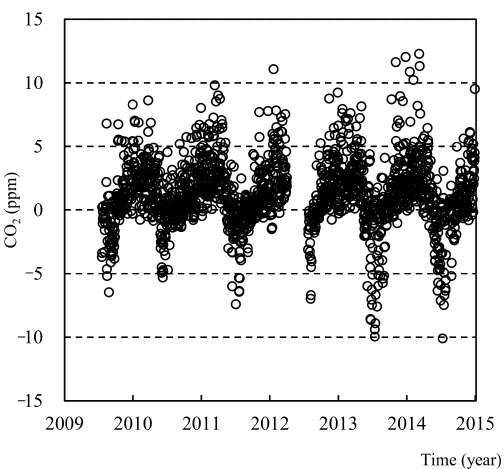
Figure 10. Difference between daily CO 2 concentrations at Mt. Fuji and Mauna Loa Observatory, 2009–2014.